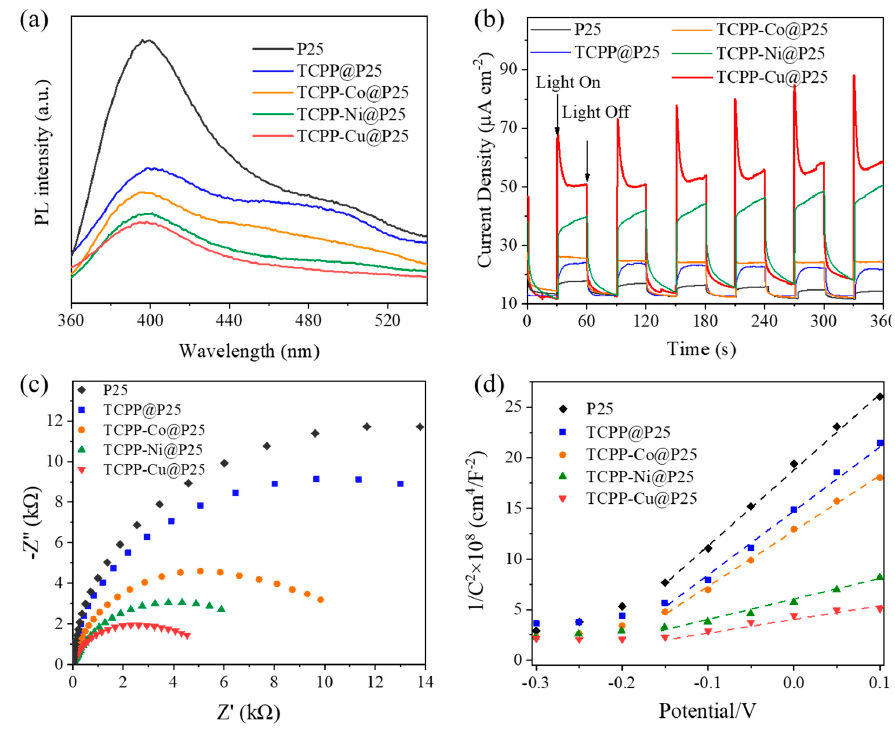
Figure 2. ( a ) PL spectra, ( b ) transient photocurrent responses, ( c ) EIS Nyquist plots, and ( d )